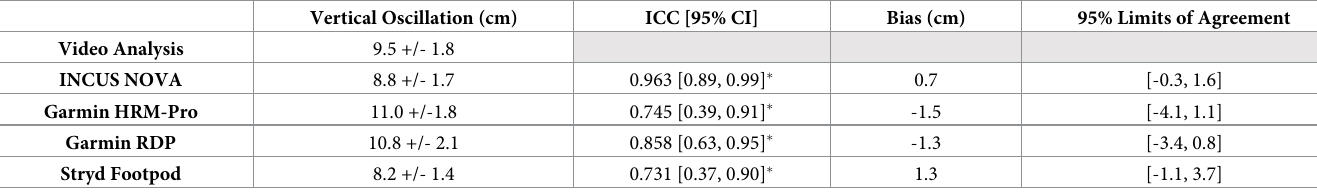
Table 2. Validity of vertical oscillation measurements from wearable devices compared to video analysis.